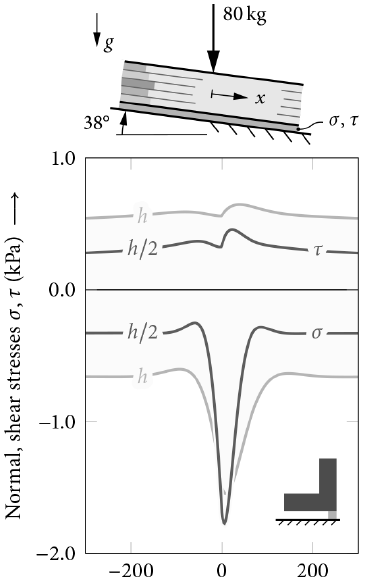
Figure 15. Effect of changes of the slab thickness h on shear and normal stress in the weak layer under skier loading, shown for pro- file F.